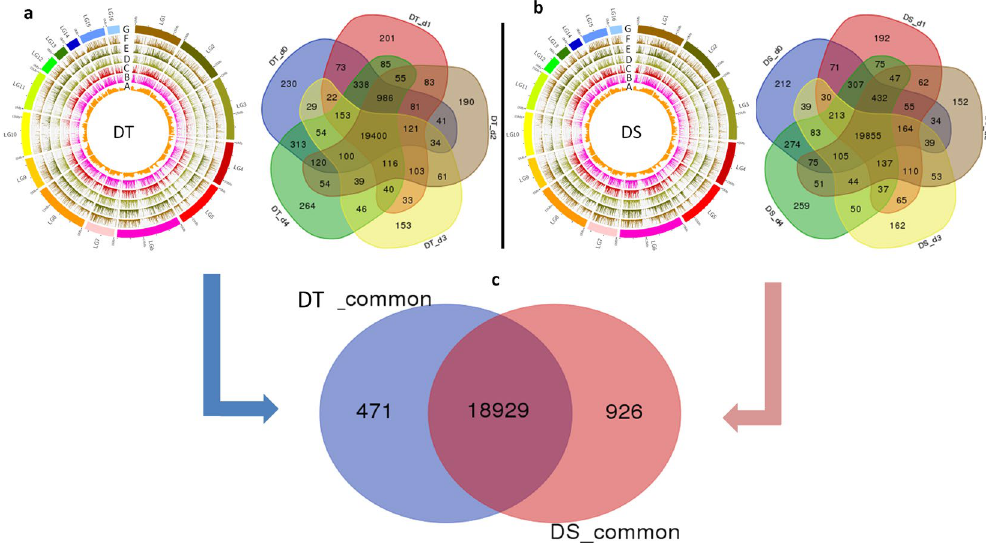
Figure 4. An overview of gene expression (FPKM) and the shared and uniquely expressed gene numbers during a time-point assay of drought stress in ( a ) tolerant (DT) and ( b ) sensitive (DS) sesame genotypes. A, B, C, D and E correspond to the samples collected at d 0 , d 1 , d 2 , d 3 and d 4 , respectively. F represents the gene density (mRNA, 500-kb window) in the sesame genome and G represents the 16 linkage groups of sesame. ( c ) The commonly shared and uniquely expressed gene numbers during all time-points in DT and DS.